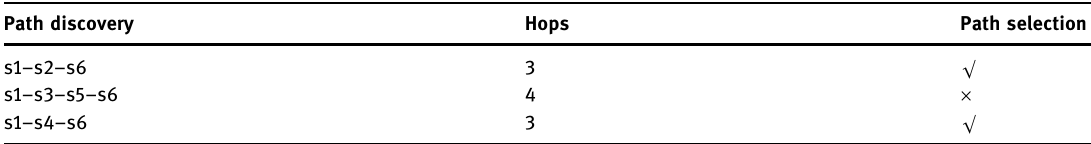
Table 2: Path discovery and selection